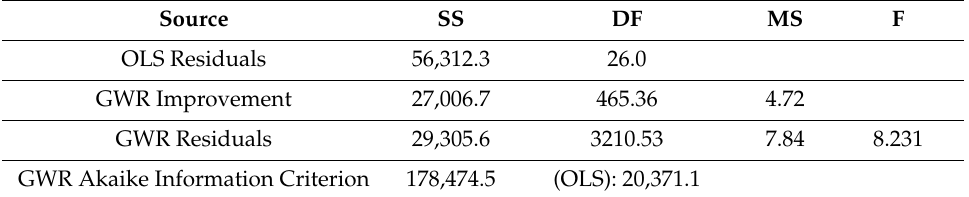
Table 6. ANOVA test of the FRS-GWR over the OLS regression